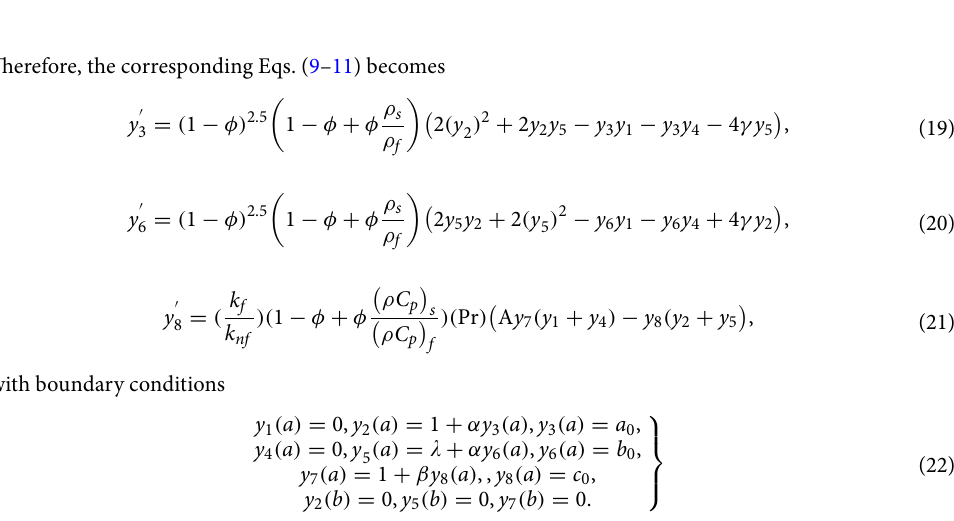
Figure 8. ( a ) The outcome of α and φ along the x-axis on skin friction for CuO nanoparticle. ( b ) The outcome of α and φ along the x-axis on skin friction for Ag